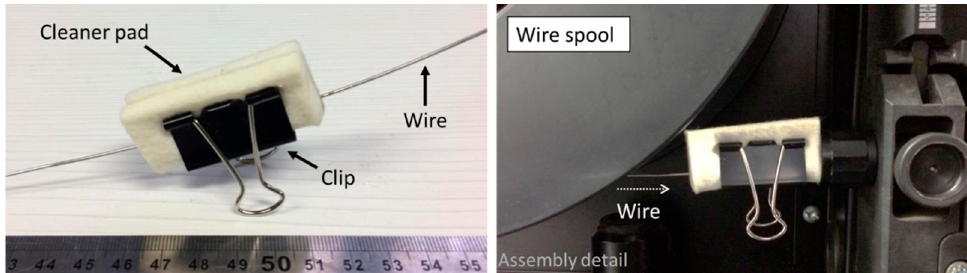
Figure 2. Cleaner pad (felt) clamped to the wire to mitigate the effect of external impurities and its assembly detail.